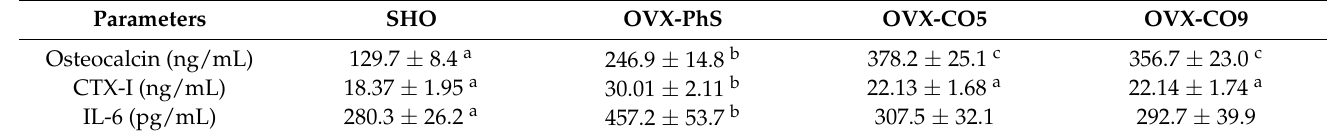
Table 4. Biochemical markers of bone